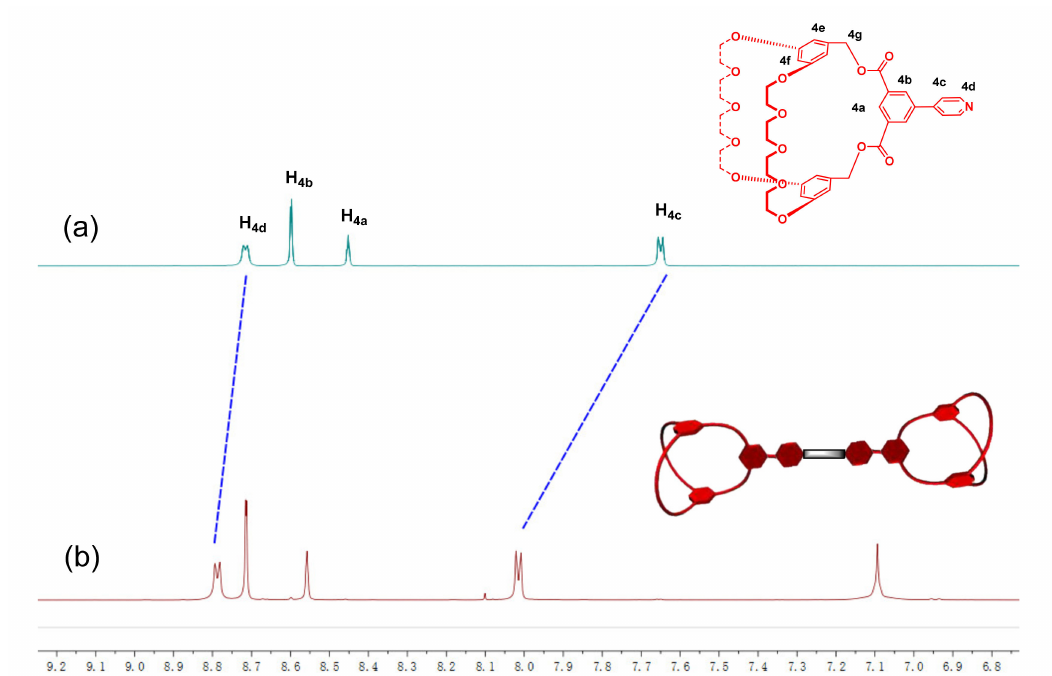
Figure 4. Partial 1 H NMR spectra (500 MHz, CD 2 Cl 2 , 298 K): ( a ) the cryptand 4 and ( b ) the di-cryptand monomer 8